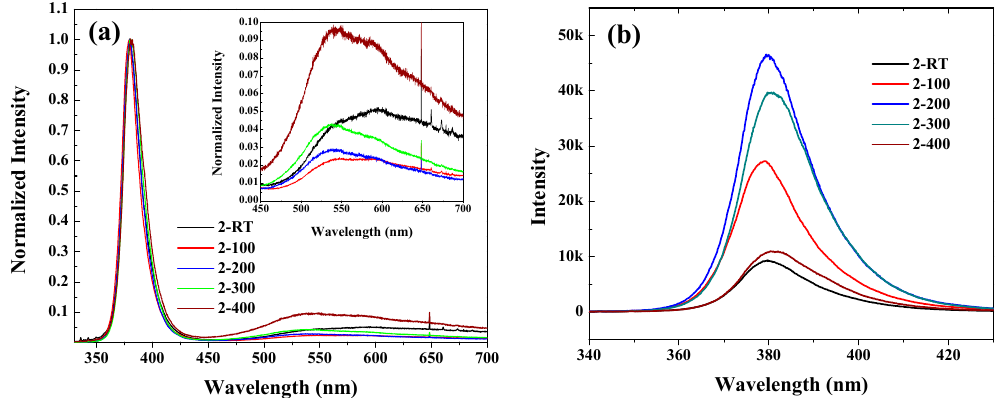
Figure 5. ( a ) Normalized photoluminescence spectra of ZnO:N films. The inset shows the enlarged photoluminescence spectra of ZnO:N films in the visual region; ( b ) Intensity of near-band emission peaks.